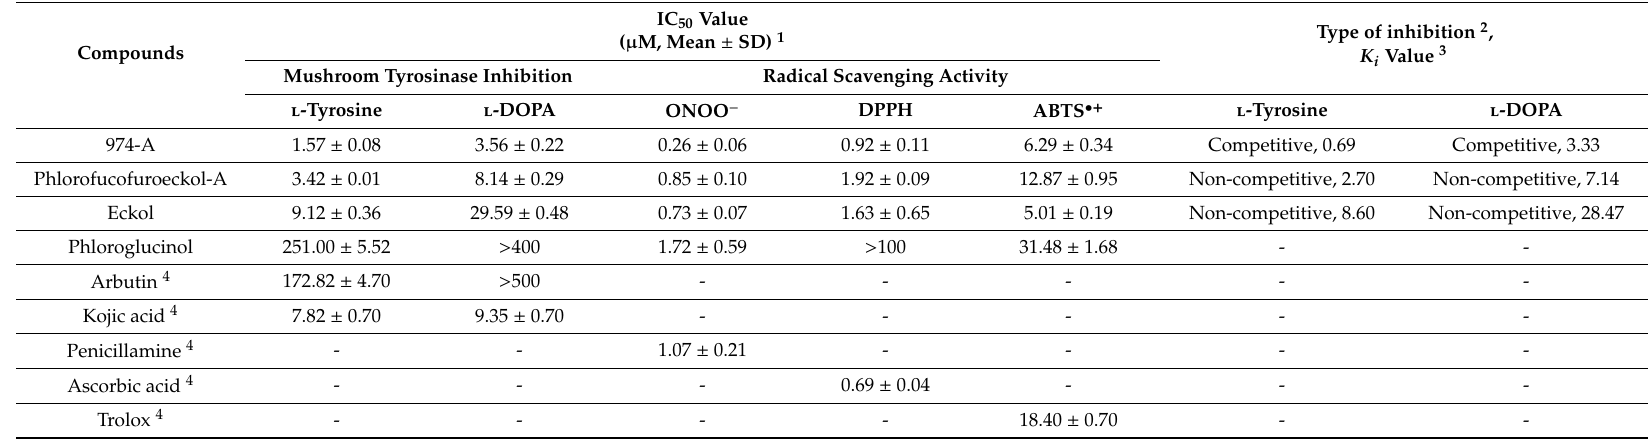
Table 1. Mushroom tyrosinase inhibitory and free radical scavenging activity of phlorotannins isolated from E. stolonifera along with the kinetic analysis of